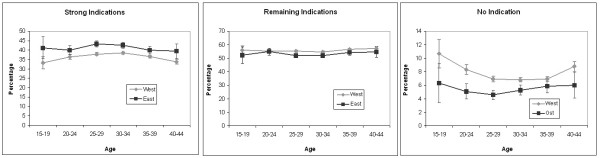
Percentage of caesarean sections with i) at least one strong indicationa, ii) with moderate indication(s), but no strong indications and iii) no indications by age and region. a As strong indications were classified: Placenta praevia, Abruptio placaente, Uterine rupture, anomalies of foetal presentation and disproportion [11].